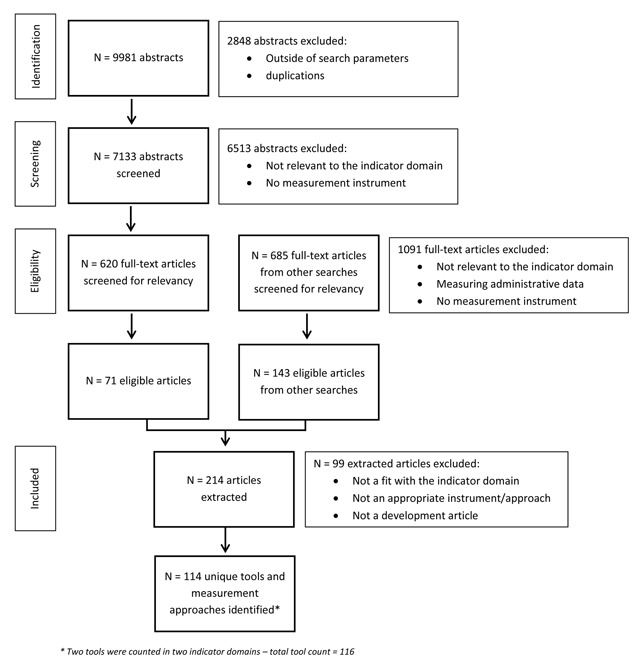
Prisma flow chart.